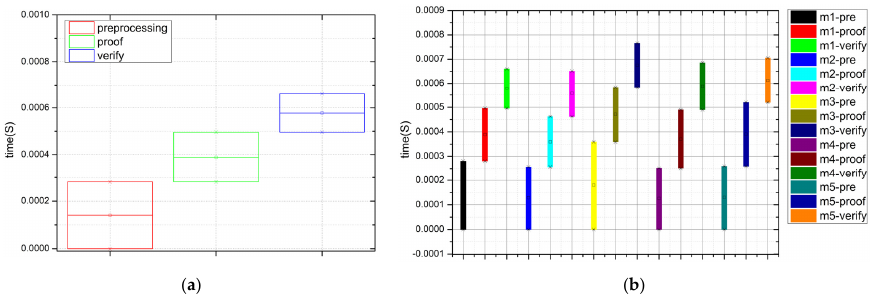
Figure 6. The timing diagram of S-DIV: ( a ) timing diagram of one message; ( b ) timing diagram of multiple messages (in the figure, m1 indicates message 1). As can be seen from Figure 6, the calculation time of one message (including each processing phase) is at the millisecond level. Although the calculation times of multiple randomly selected messages are different from each other, all calculation times are within